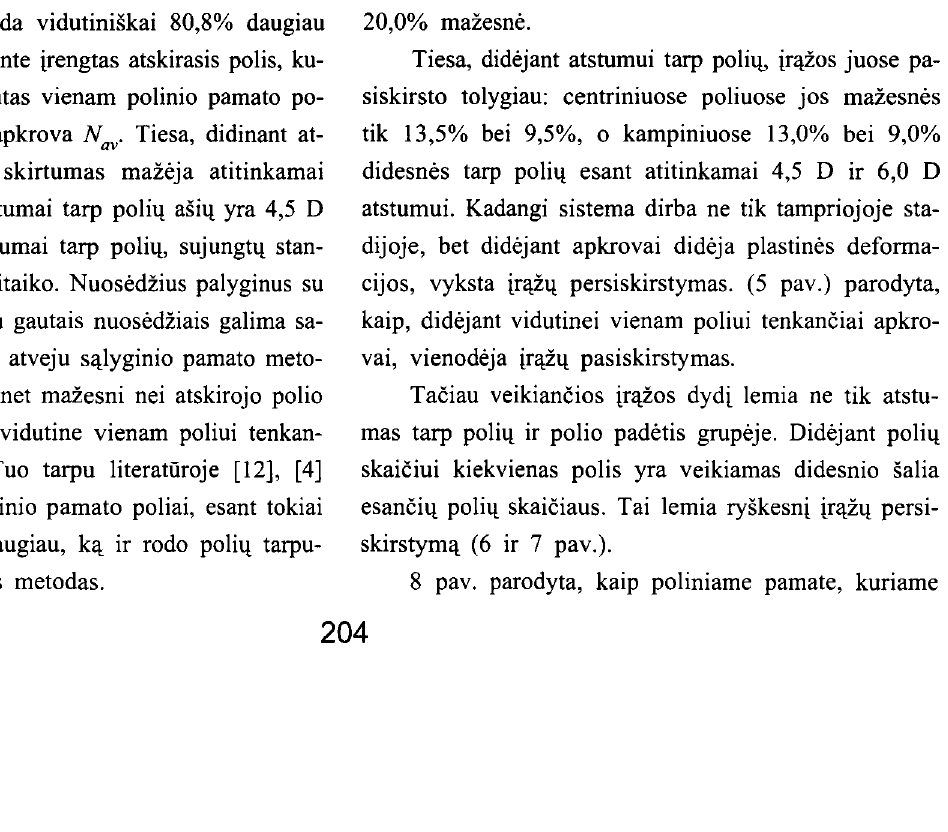
Fig 4. Pile foundation settlement relationship for avera ge load of one pile and normalised pile spacing r/D: I - single pile, 2 - 5x5 pile foundation, calculated like equi valent raft foundation, 3, 4 and 5 - using interaction coefficient and between pile axes being distance 3 D, 4,~ D and 6 D (Bergamo, ltalija) Geotechnikos laboratorijos poliq gro pes PG5T_30 tyriml! rezultatq duomenimis. S<tveikos koeficientas nustatytas remiantis eksperimentiniais poliq grupiq tyrimq rezultatais [11]. Ten pat yra pateiktas siuo metu turimq teoriniq S<tveikos koeficientq reiksmiq palyginimas su eksperimentinemis, is kuriq matyti, kad siuo metu dar nera palyginti tikslaus sio koeficiento skai ciavimo metodo.